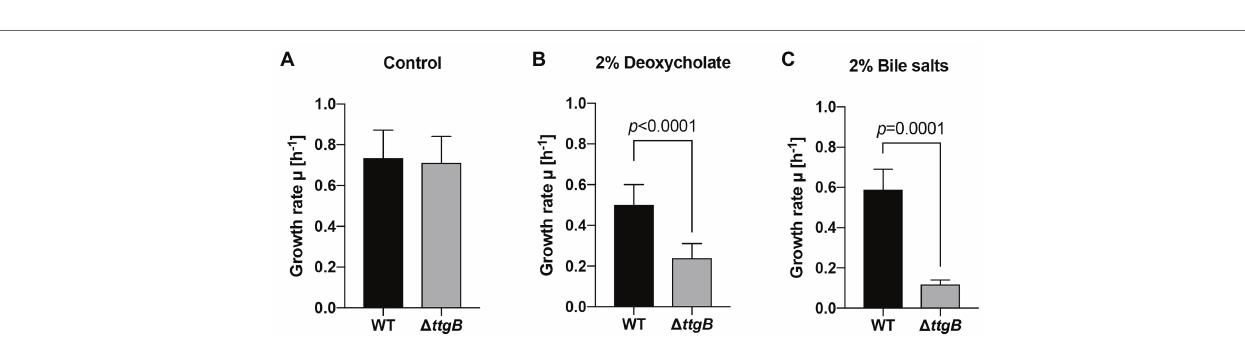
FIGURE 7 | Resistance of Pseudonomas putida KT2440 to deoxycholate 2% and bile salts 2% is related to TtgABC activity. (A) Growth rates of WT and Δ ttgB strain were assessed in Mueller Hinton (MH) medium without addition (control), (B) in the presence of 2% deoxycholate and (C) in the presence of 2% bile salts. Growth was recorder by measuring OD600 in Tecan reader (Tecan infinite ® M200 pro plate reader, settings: 30 ° C, shaking with orbital amplitude of 2 mm). Growth rates were determined from the exponential growth phase. All experiments were performed a minimum of three